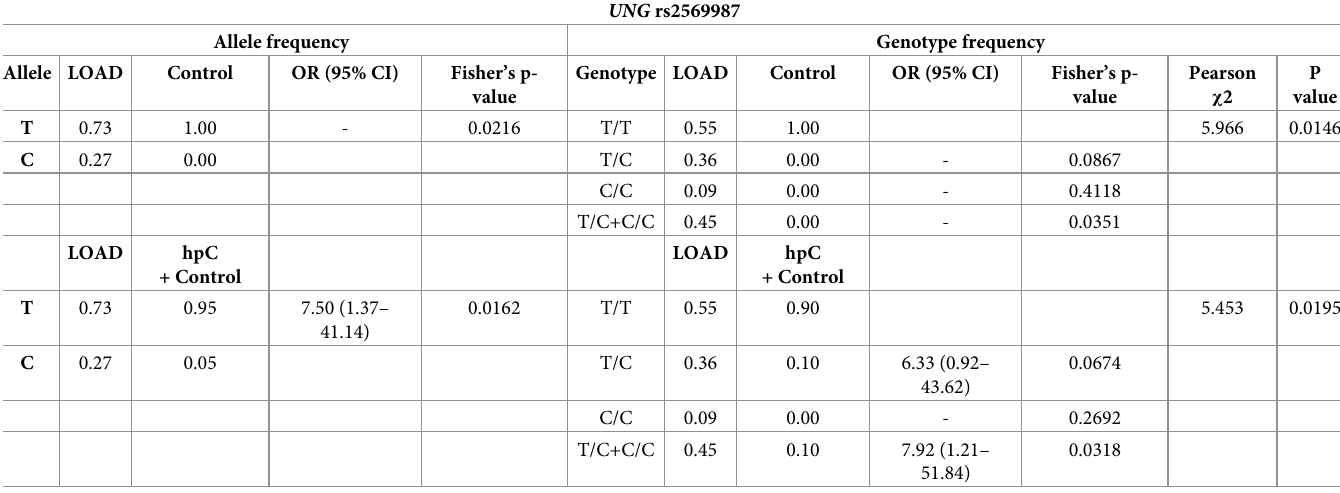
Table 8. Allele and genotype frequencies of UNG rs2569987 in CE of LOAD patients, hpC and age-matched cognitively normal controls subjects (LOAD = 11, hpC = 11, Control =